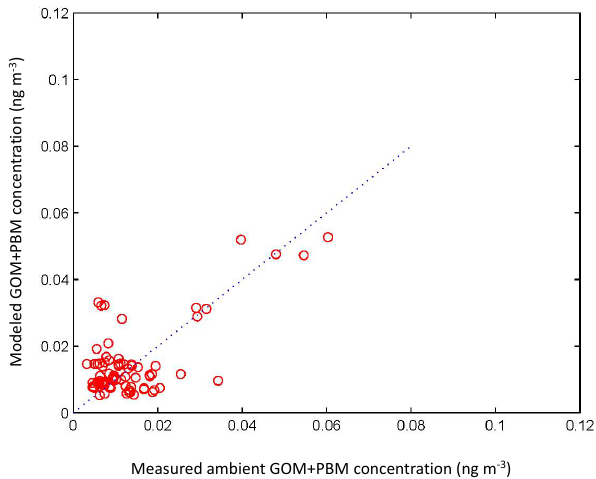
Fig. 5. Scatter plot of modelled and measured ambient GOM+PBM for 2010 validation data.